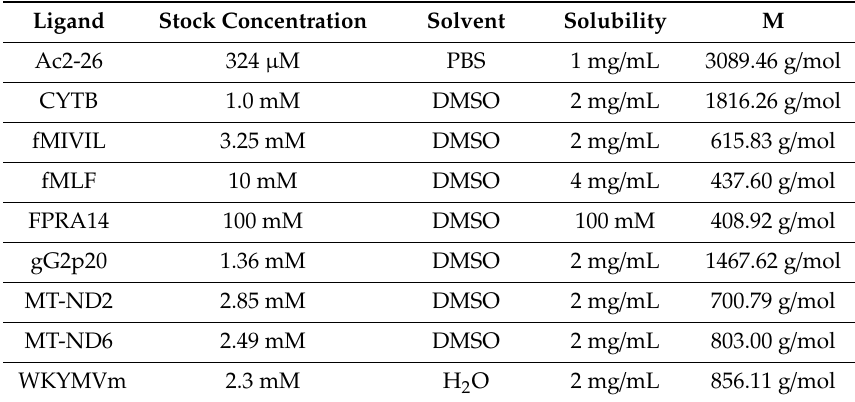
Table A1. Ligand stock solutions. Concentrations of stock solutions were calculated based on the solubility of the compound as indicated by the manufacturer and its molecular weight (M). Stock solutions were prepared using the solvents recommended by the manufacturer.